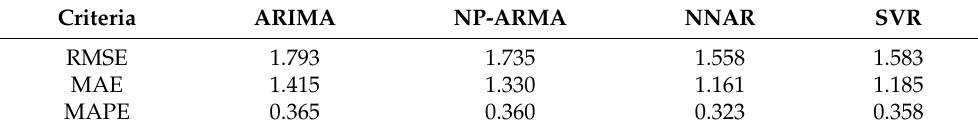
Table 13. The error metrics.